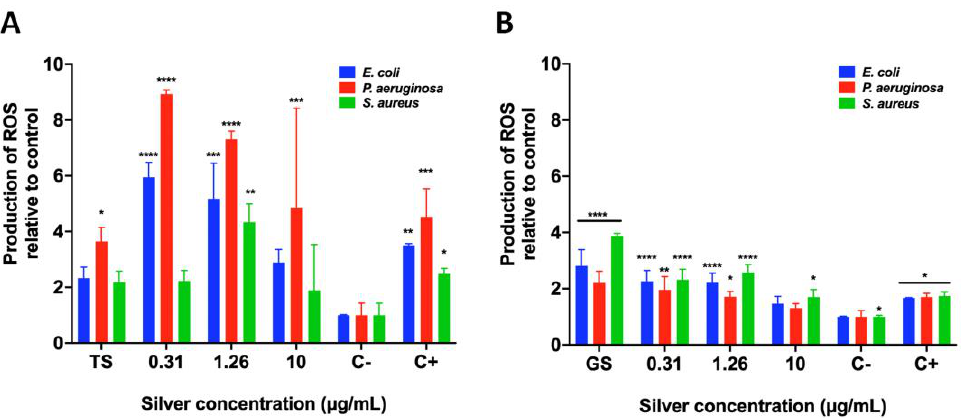
Figure 9. ROS production by biosynthesized AgNPs using supernatants of T. harzianum ( A ) and G. sessile ( B ) against E. coli , P. aeruginosa and S. aureus . TS = T. harzianum supernatant, GS = G. sessile supernatant. Results are expressed as the mean ± SD (n = 3) * p < 0.05; ** p < 0.01; *** p < 0.001, **** p < 0.0001 using two-way ANOVA with a Dunnett’s multiple comparisons tests.